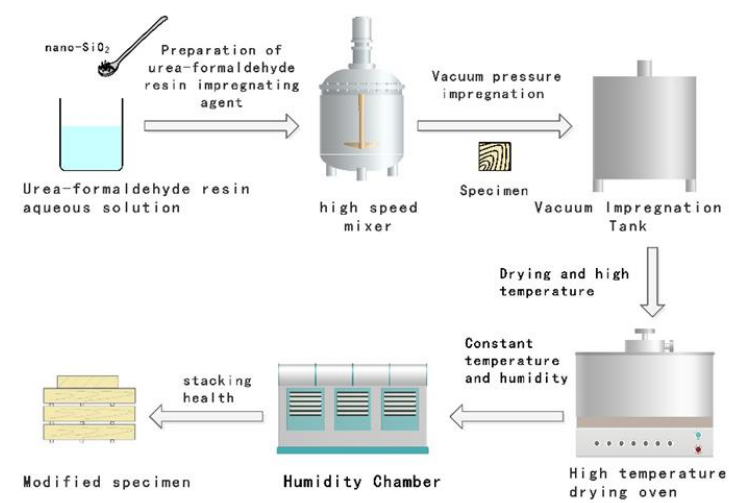
Figure 1. Impregnation high-temperature heat treatment integrated process.